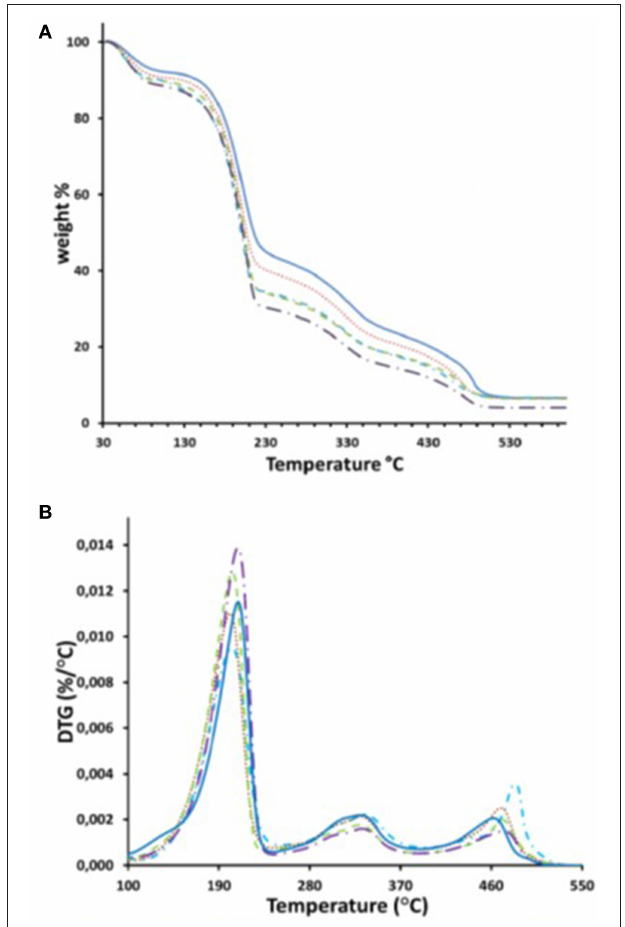
FIGURE 4 | (A) TGA and (B) DTG analysis evaluated on TPs100HNTs-carv0 ( ), TPs97.5HNTs-carv2.5 ( ), TPs95HNTs-carv5 ( ), TPs90HNTs-carv10 ( ), TPs80HNTs-carv20 ( ).